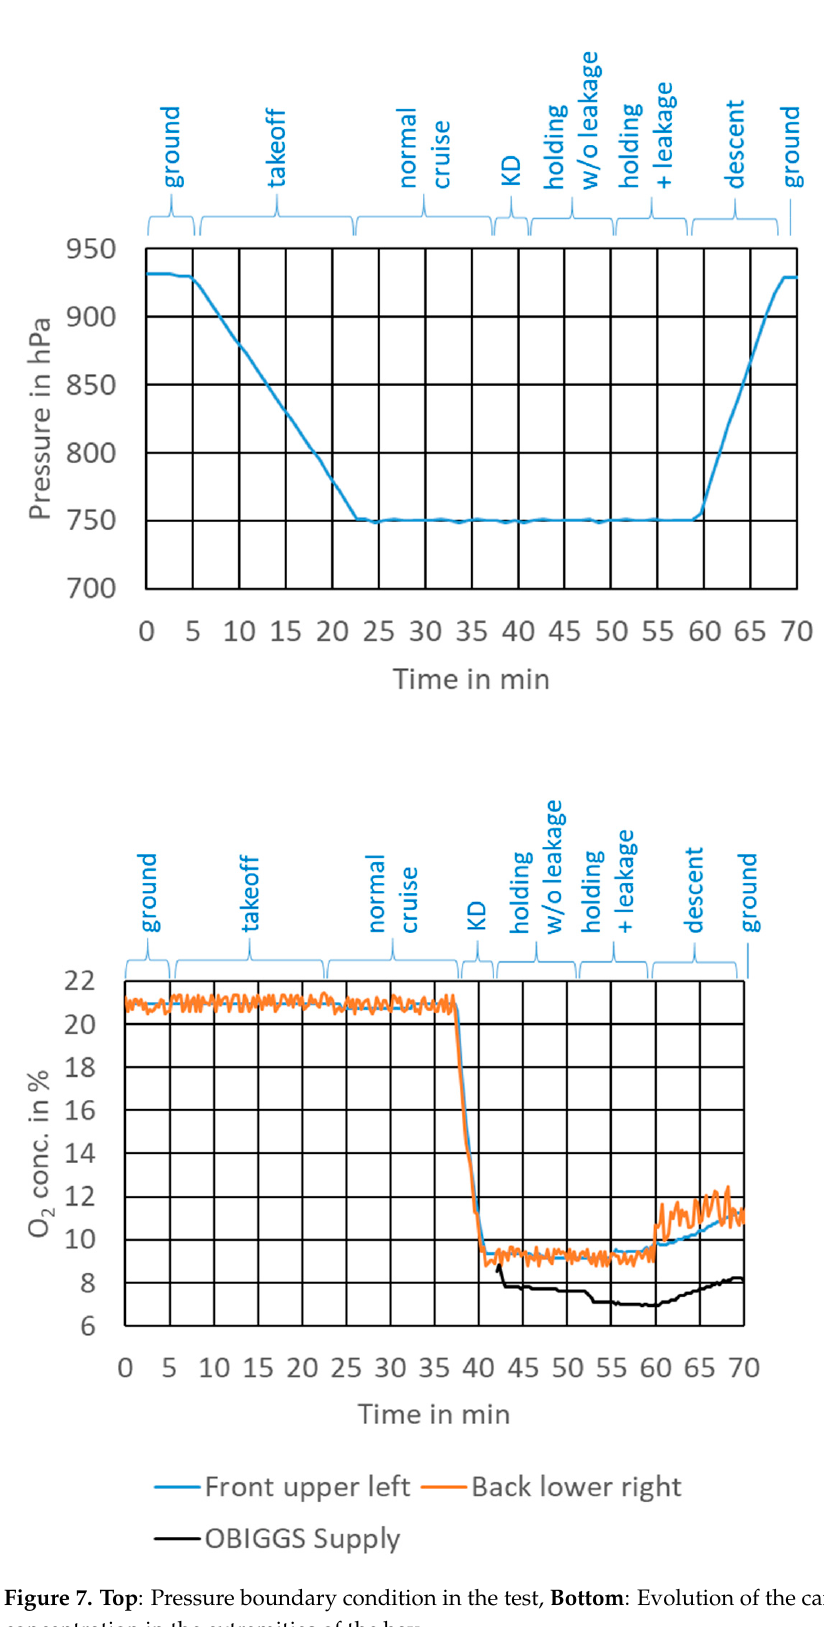
Figure 7. Top : Pressure boundary condition in the test, Bottom : Evolution of the cargo hold oxygen concentration in the extremities of the bay.